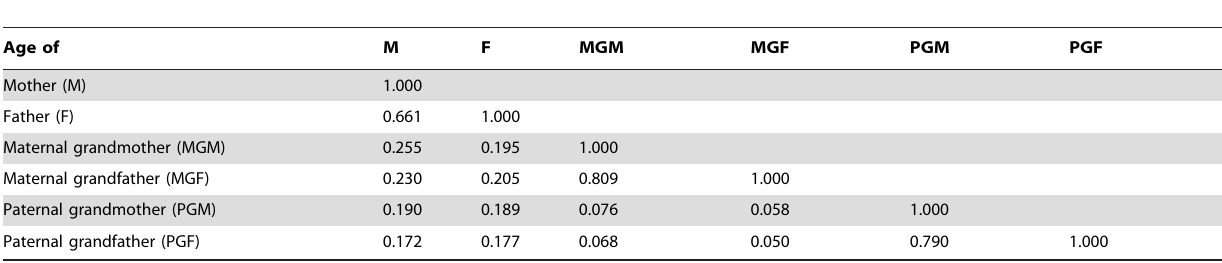
Table 5. Correlations between parental and grandparental ages–all study families.